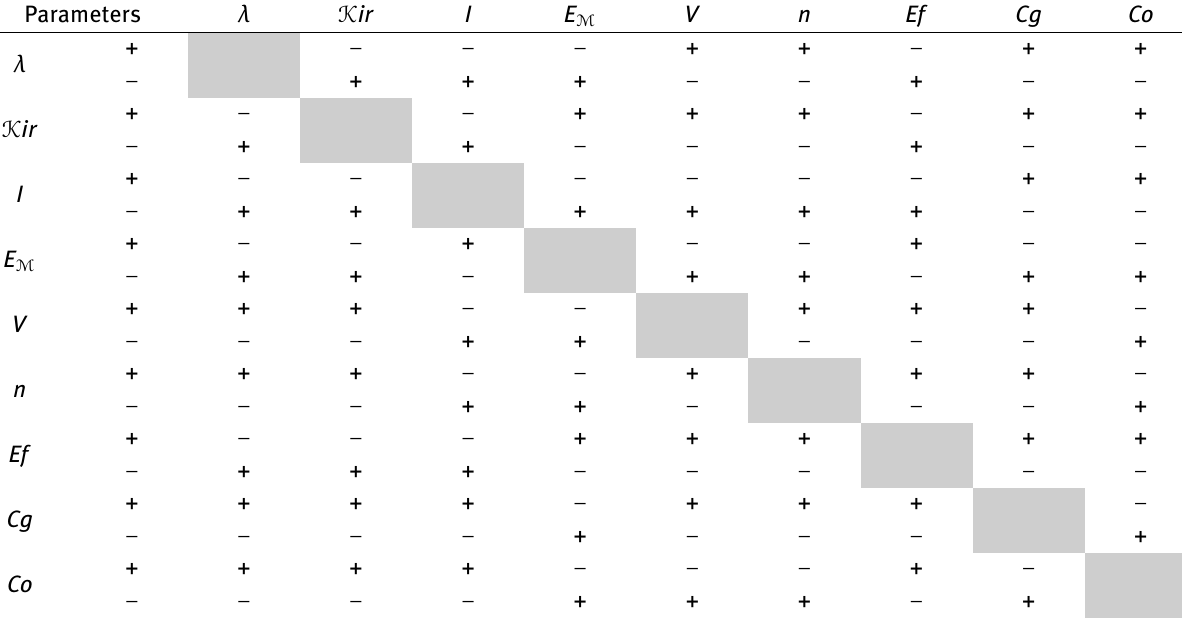
Table 1: Matrix of interrelations between main parameters of a dry port. Parameters